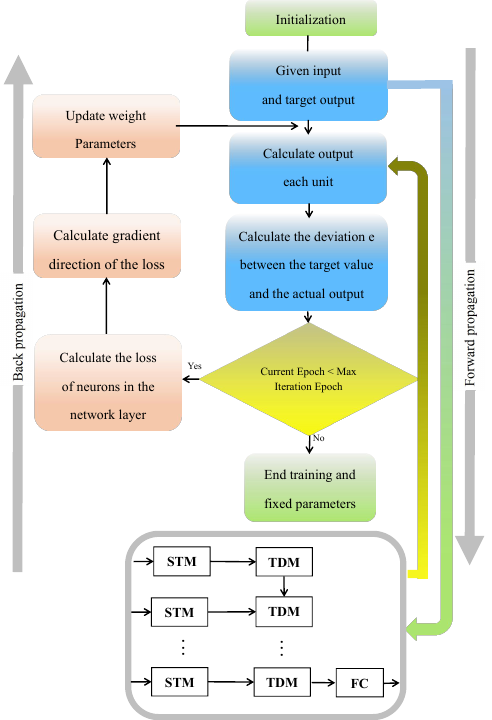
Figure 2. The pipeline of the proposed static transformer temporal differential network.